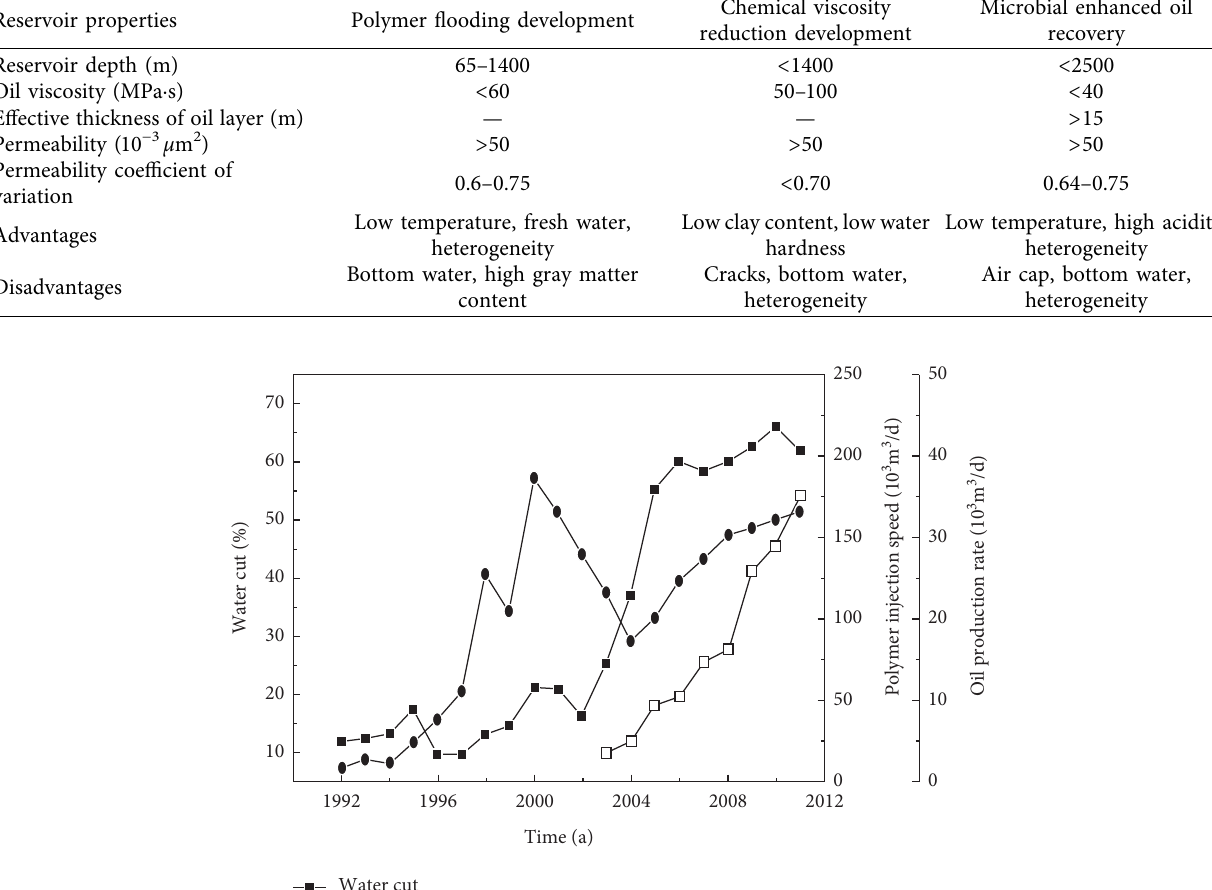
Table 2: Production characteristics and reservoir adaptability of different heavy oil cold recovery techniques.